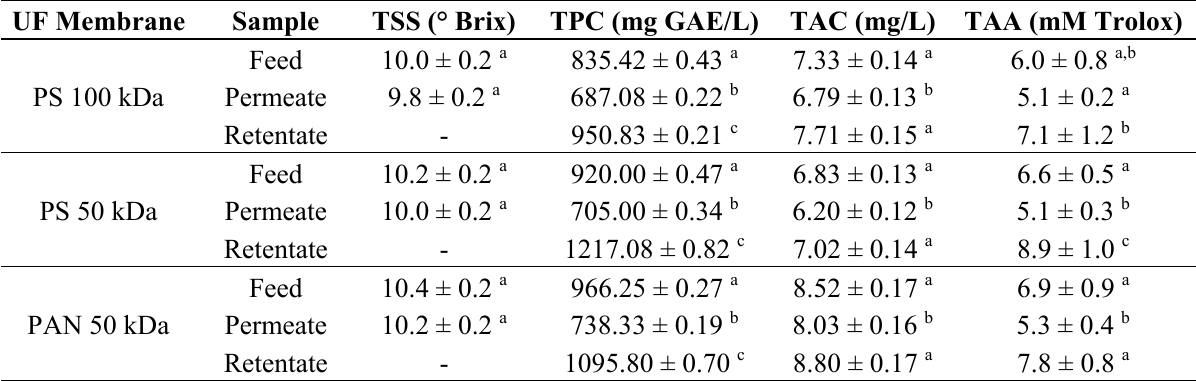
Table 3. Effect of different hollow fiber UF membranes on TSS, TPC, TAC, and TAA of blood orange juice.